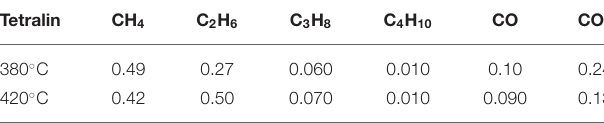
TABLE 6 | Oil yield, transformation rate, and residue rate in liquefaction of WCW. Temperature